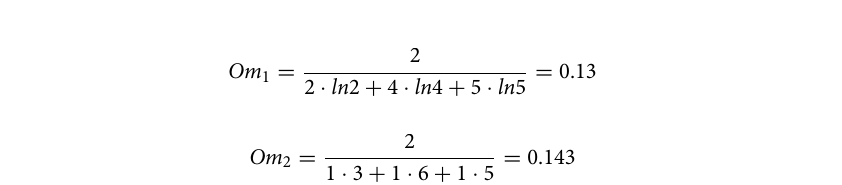
Figure 4. Parametrization of the selected graph from the viewpoint of modularity level